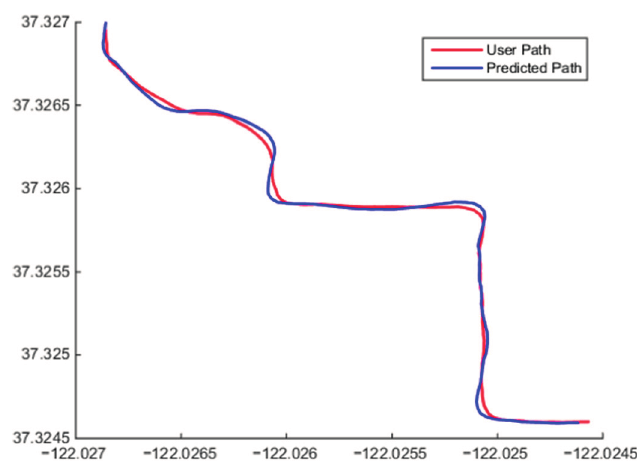
Figure 5. Beginning of the output showing the identification of Ω between predictions methods for states Ω general linear behaviour to general non-linear behaviour.